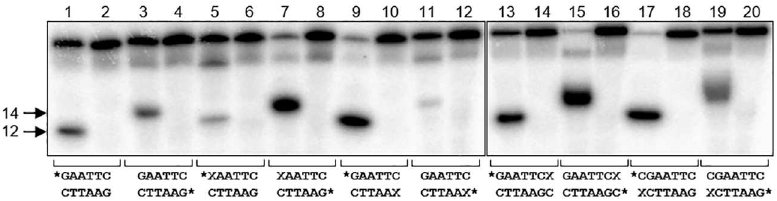
Fig 1. Cleavage of native and oxoG-modified GAATTC sequence by Eco RI. Odd lanes, enzyme added (300 pM); even lanes, no enzyme (controls). The concentration of the substrate was 100 nM. The central part of the 30-mer duplexesand the position of oxoG (X) and radioactivelabel (asterisk) are shown below the image. Cleavageof the top strand produces a 12-mer product; cleavageof the bottom strand produces a 14-mer product.